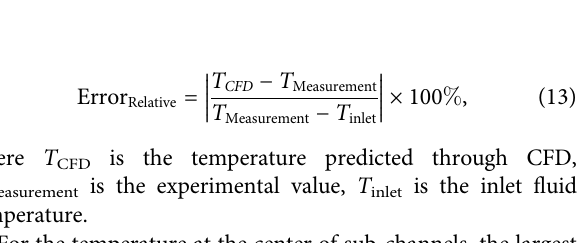
FIGURE 16 | Cumulative frequency distribution histogram (without ML1). (A) Deviation for sub-channel temperature. (B) Deviation for rod surface